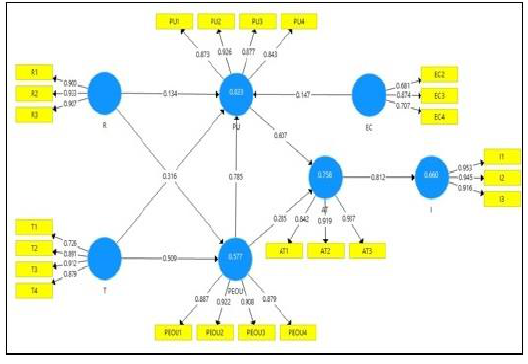
Figure 6. Path Analysis of